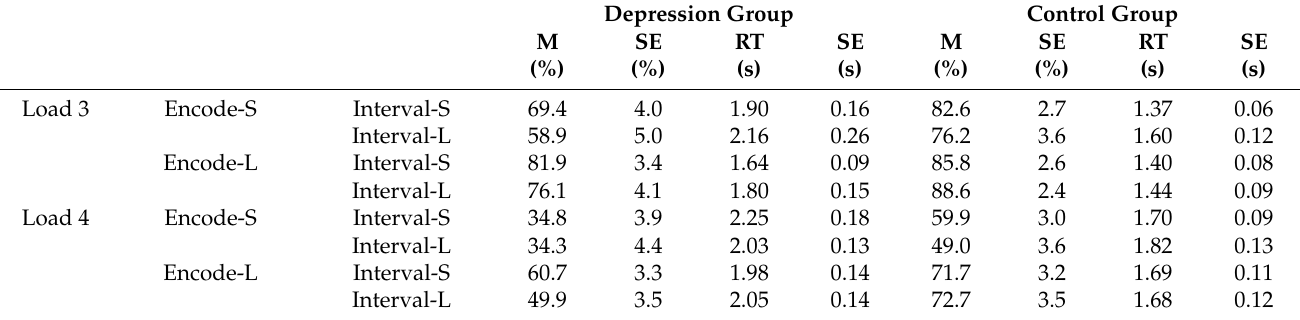
Table 2. Mean accuracies (M) and reaction times (RT) with standard errors (SE) in each experimental condition for each group. Encode-S: short time for stimulus encoding; Encode-L: long time for stimulus encoding; Interval-S: short retention interval; Interval-L: long retention interval. Depression Group Control